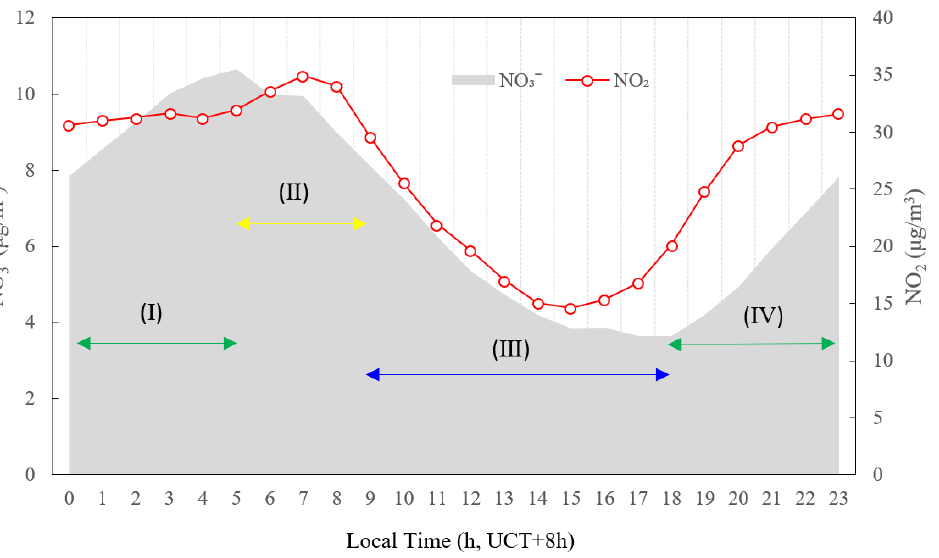
Figure 12. Diurnal variation in NO 3 − and NO 2 concentrations averaged under the photochemical activity levels M, LH and H, in summertime 2020 in Tianjin, China. Stage I, 0:00 – 5:00; Stage II, 5:00 – 9:00; Stage III, 9:00 – 18:00; Stage IV, 18:00 – 23:00.